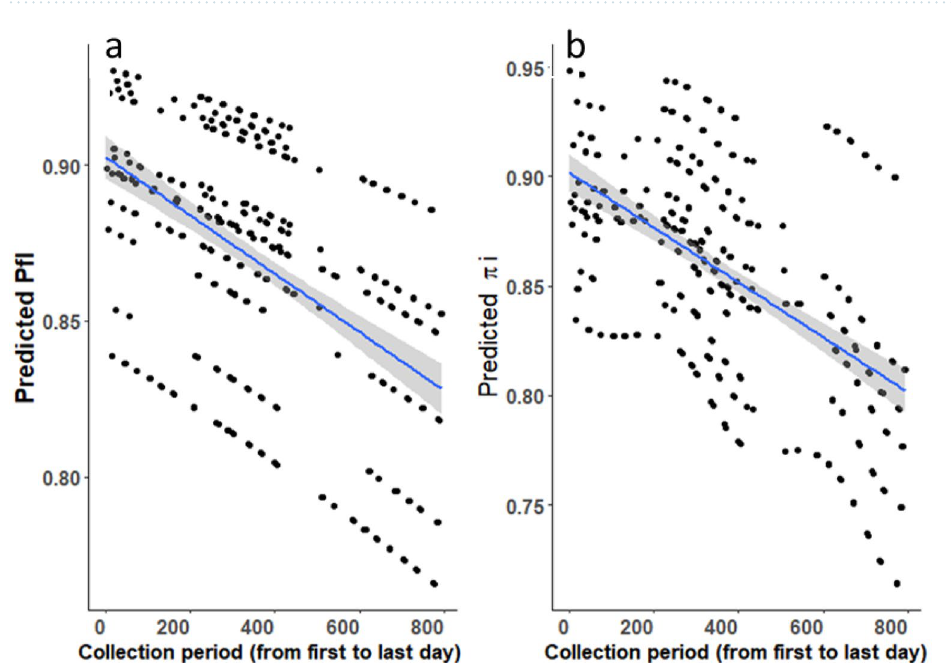
Figure 4. Predicted mean of ( a ) P fl = the proportion of An. gambiae s.l. bites occurring when most people are inside their dwellings and likely asleep (e.g. between 10 pm and 5 am; P fl ), ( b ) π i = total human exposure to An. gambiae s.l. bites occurring indoors (π i ) based on Human Landing Catch from 6 villages over 2 years (Oct 1st, 2016 to Dec 4th, 2018) in southwestern Burkina Faso. Dots represent the predicted values (P fl and π i ) at each sampling night. The blue lines represent the regression lines from the models and the grey-shaded area the 95% confidence